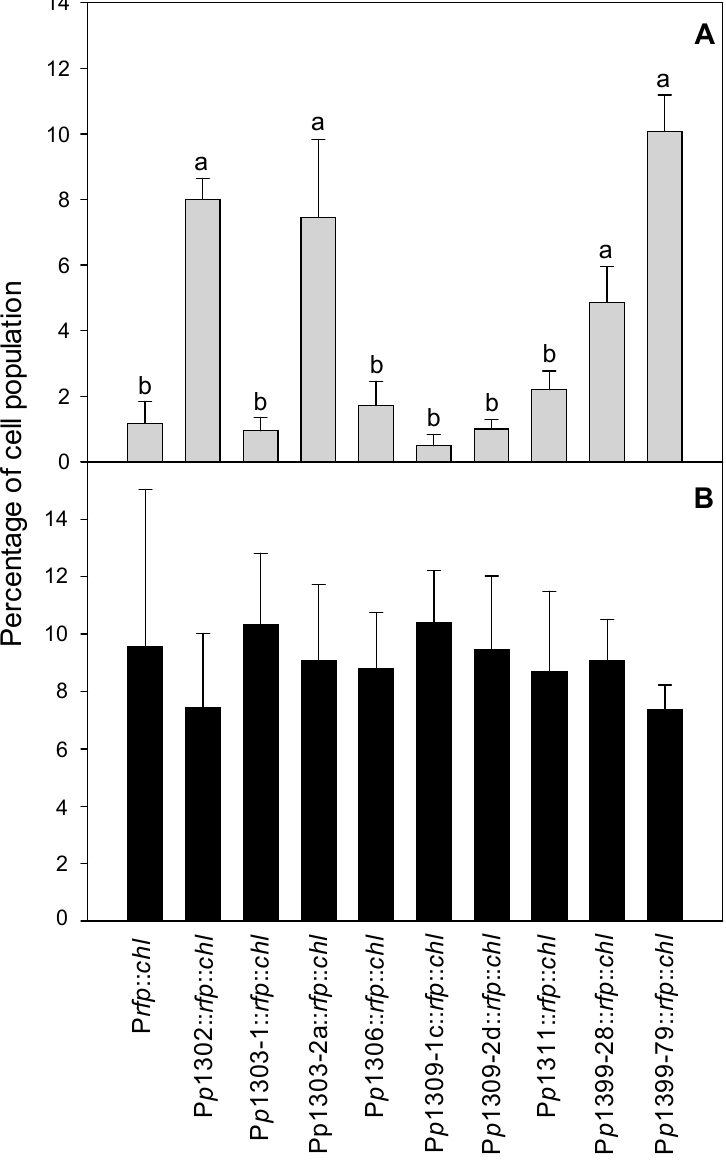
Figure 6. Expression of GFP and DsRed by E. coli O104:H4 11-3088 ∆ stx :: gfp :: amp r (P p R’:: rfp :: chl r ) transformants after MMC induction. ( A ) Percentage of the population expressing plasmid-encoded DsRed under control of the plasmid-encoded promotor indicated. The promotorless plasmid P rfp :: chl r served as the negative control. ( B ) Percentage of the population expressing the chromosomal gene coding for GFP under control of the native promotor. The percentage of the red or green fluorescent cell population was determined by flow cytometric analysis and is shown as mean ± standard deviations of quadruplicate independent experiments. Bars that do not share a common letter are significantly different ( p ≤ 0.05).